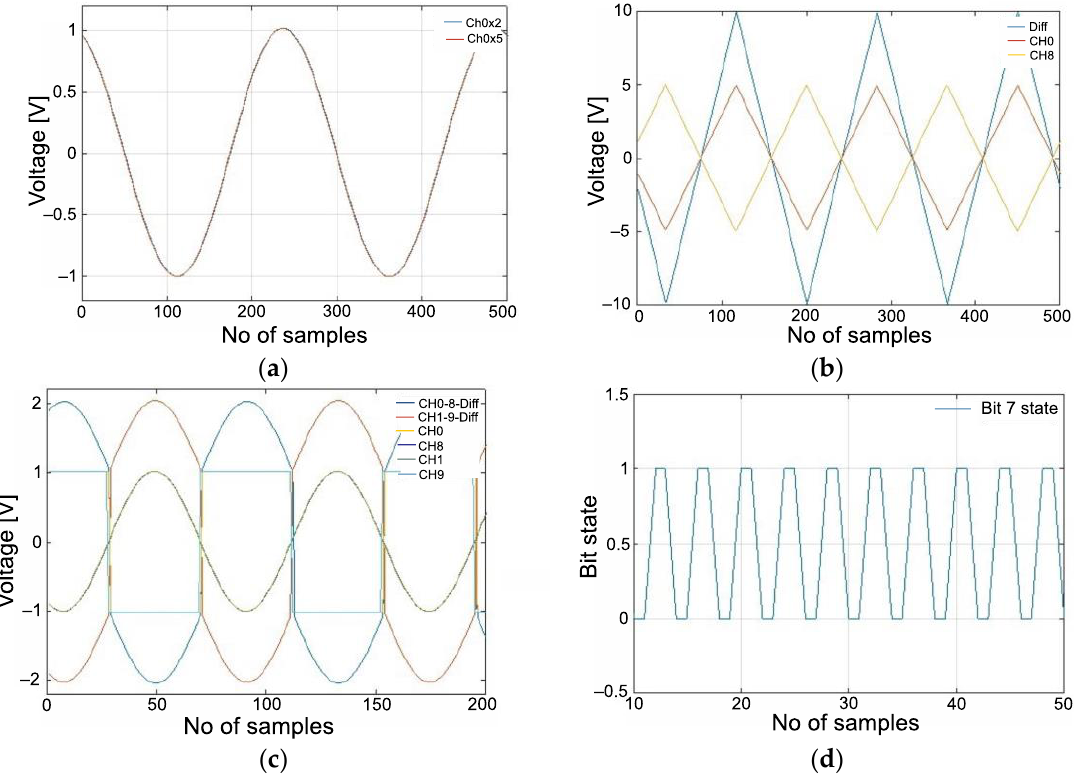
Figure 10. Repeated verification of the gain ( a ); verification of the differential measurements ( b ); test of the differential measurement with gain ( c ); state of the digital input during verification ( d ).